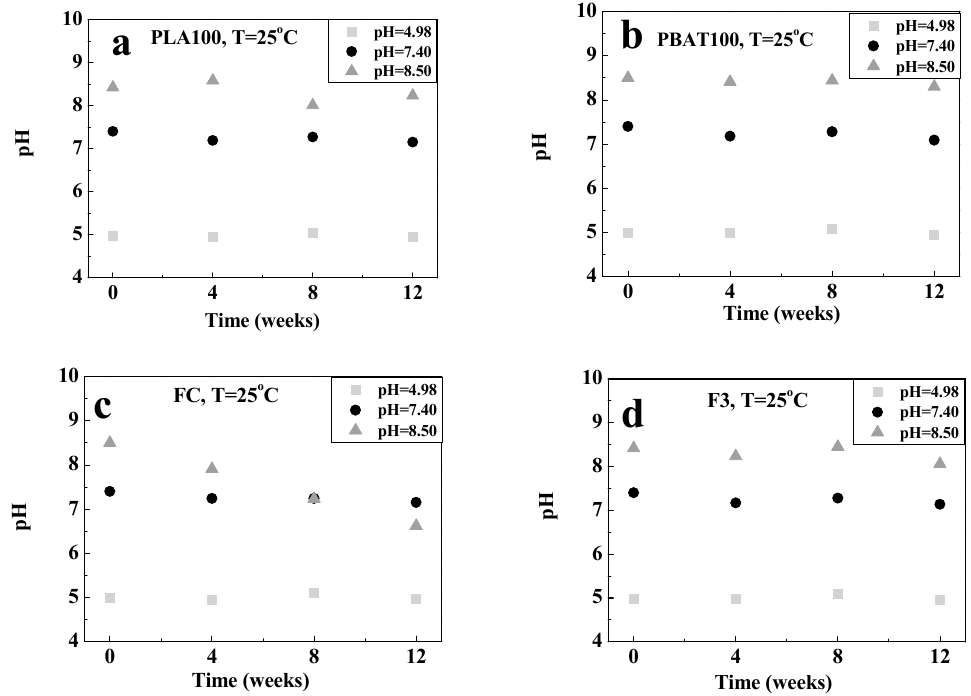
Figure 8. Variation in the pH of the buffer solutions used for degradation at 25 °C with time for: ( a ) PLA100, ( b ) PBAT100, ( c ) FC, and ( d ) F3.